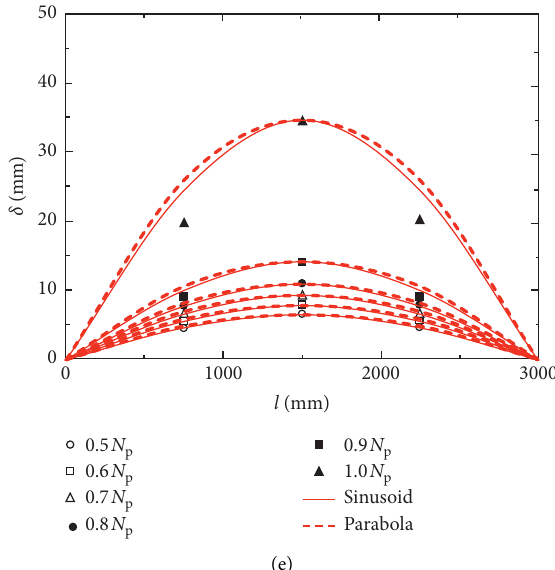
Figure 8: Typical vertical deformed shapes along the length of specimens. (a) PB-2. (b) FLB-2-F2. (c) FLB-1-S1. (d) EPB-1-N. (e)